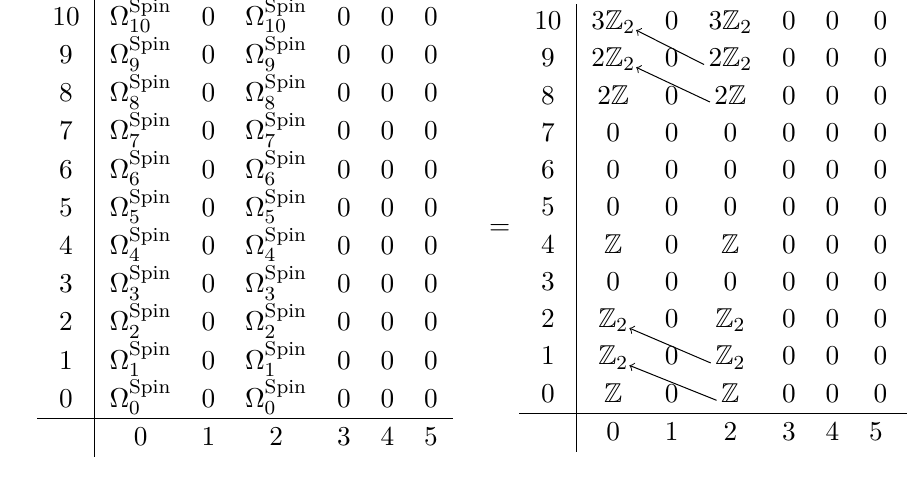
Table 5 . Second (and final) page of AHSS for Ω Spin